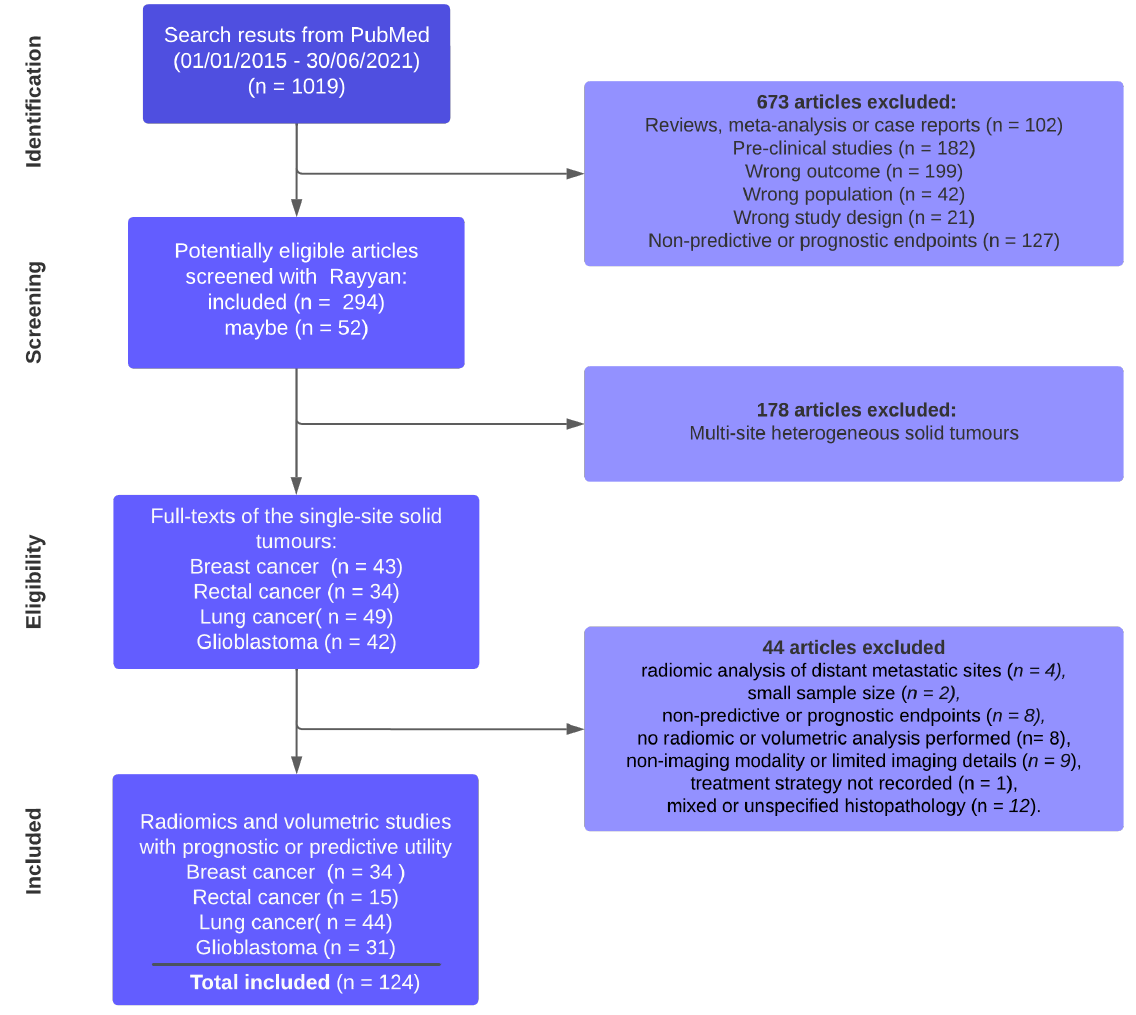
Figure 1. Flow diagram of studies selection process.